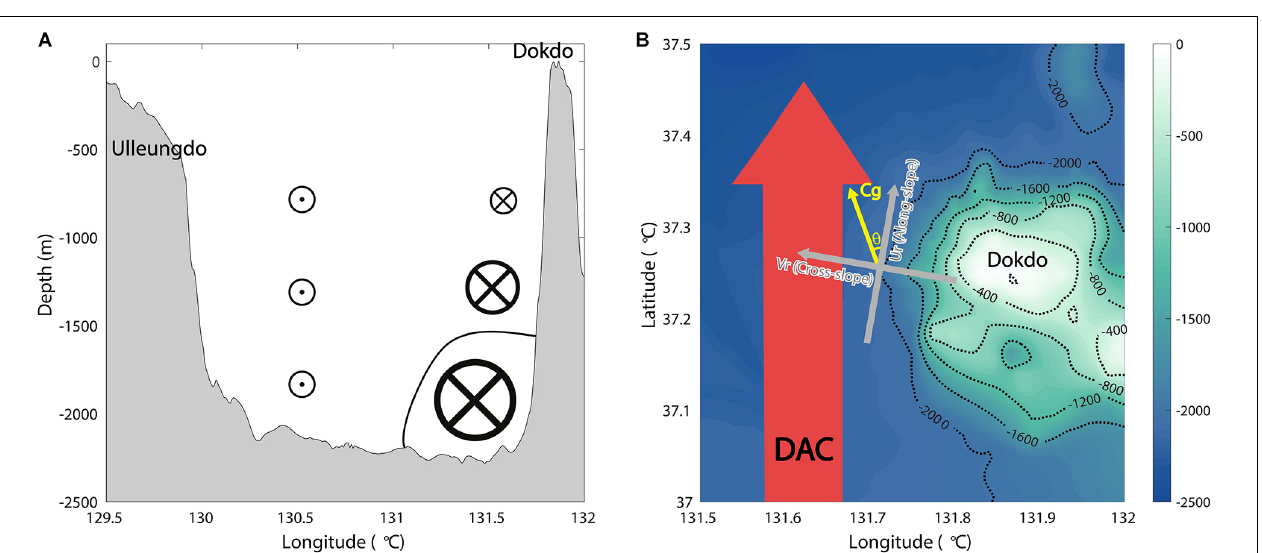
resulting in longer wavelength, larger vertical trapping scale, lower propagating speed, and smaller θ e . The HYCOM results yield wavelengths of 54–86 km and a propagating speed of 1.44– 2.30 km day − 1 for Case 4, in which the bottom intensification is the strongest. The vertical trapping scales of the HYCOM